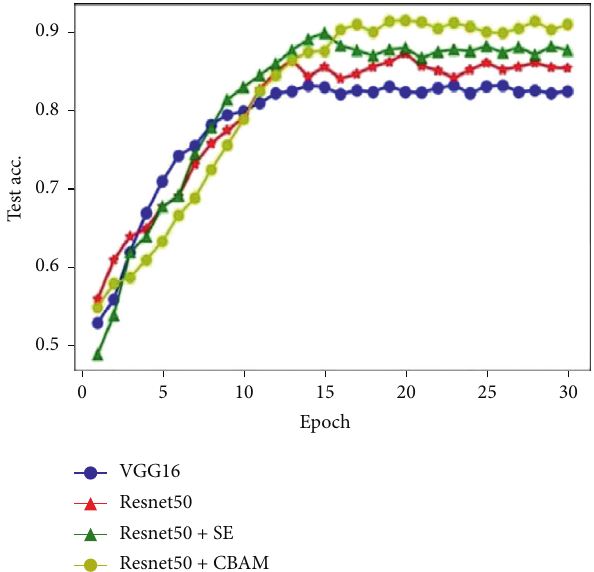
Figure 8: Testing accuracy for each training epoch for crash ap- pearance